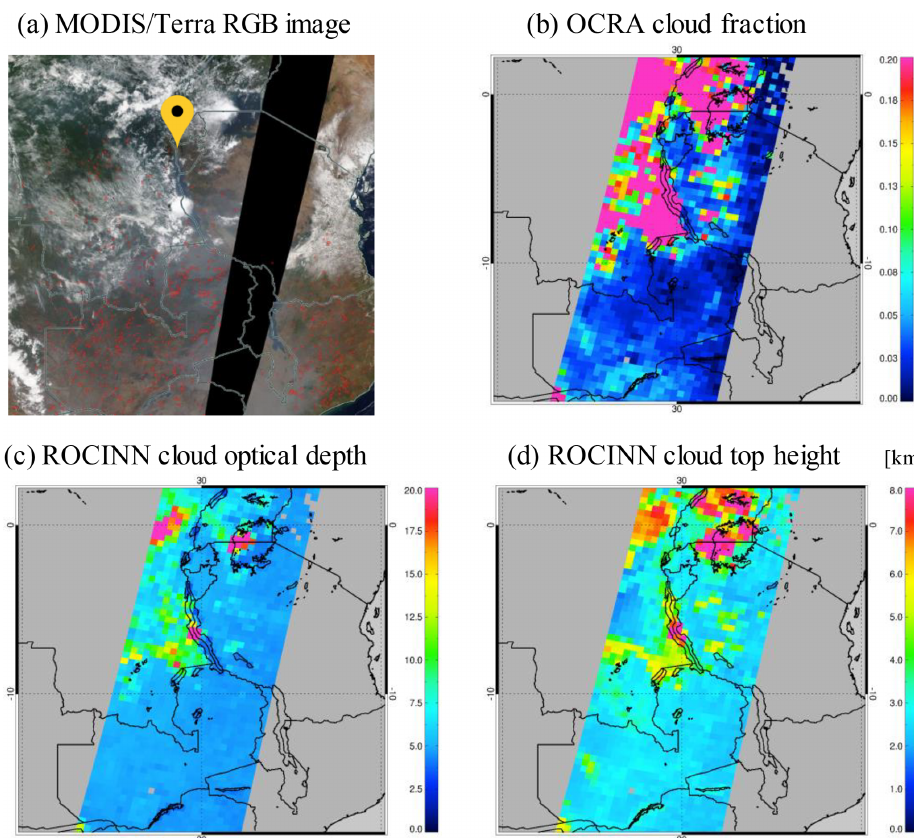
Figure 15. Similar to Fig. 14 but for central Africa on 9 September 2015. The yellow location symbol in MODIS image indicates Bujumbura station (3.38 ◦ S, 29.38 ◦